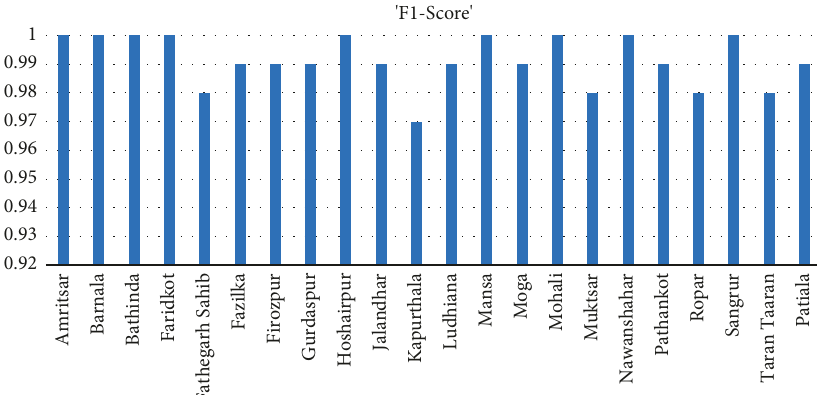
Figure 8: F1-score for each